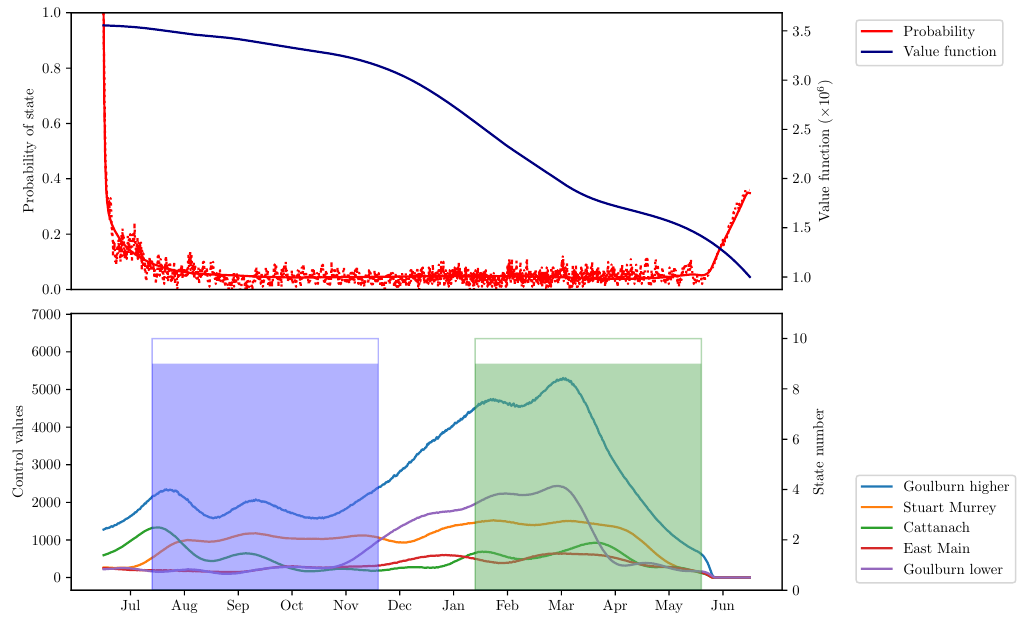
Figure 4. Probability of the state X 1 ( t ) = 9, X 2 ( t ) = 9, corresponding value function component ϕ 9,9 and optimal Markov control u ∗